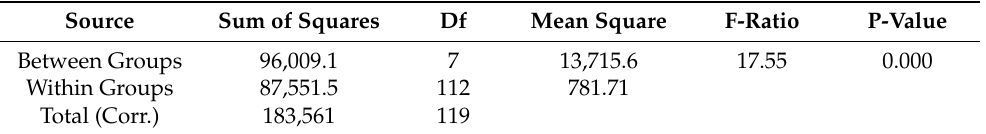
Table 4. ANOVA table for Col_4 Time-to-ignition by Col_1 heat flux.